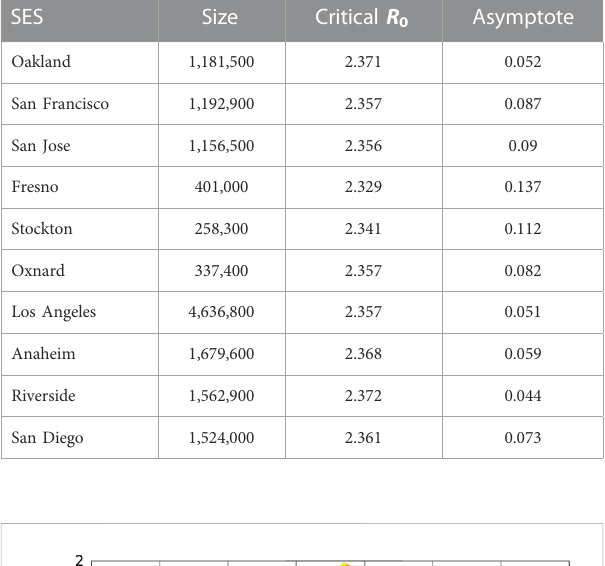
TABLE 2 SES size (number of employees on 1 March 2020), critical values of R 0 (logistic in fl ection point), and asymptotic cascade value, that is, the fraction of employment reduction as R 0 approaches 4.0.